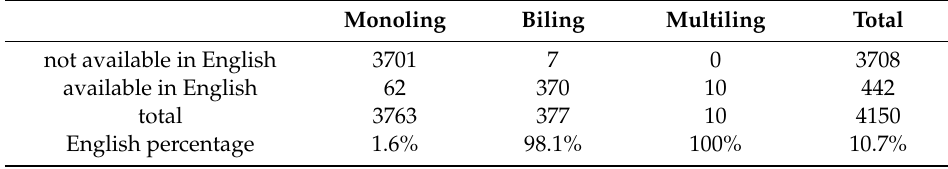
Table A22. English language availability (de).